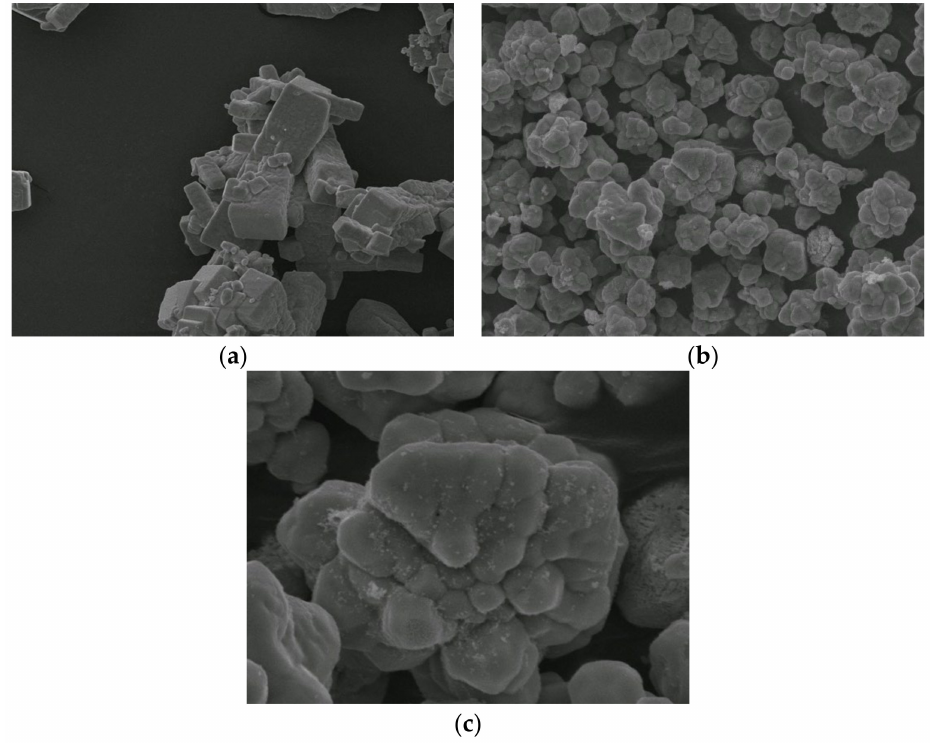
Figure 3. SEM images of ( a ) BiVO 4, ( b ) 1% Pd/BiVO 4 ( × 5000), and ( c ) 1% Pd/BiVO 4 ( × 20,000). TEM images of 1% Pd/BiPO 4 are displayed in Figure 4a,b, and the Pd nanoparticles loaded on the surface of BiVO 4 are observed. It seems that BiVO 4 has palladium not only on the surface but also in the inner structure. Figure 4a shows a nearly uniform distribution of black spots. In the TEM image with a larger magnification (Figure 4b), the crystalline lattice space obtained from the line width was 0.29 nm, which was identified as the (040) crystal plane of BiVO 4 . In addition, a 0.23 nm interfringe distance was observed, which was close to the lattice spacing of the (111) crystal plane of Pd. This result indicates the high dispersion of the Pd nanoparticles which could favor the electron collections. The elemental composition of the synthesized 1% Pd/BiVO 4 was elucidated using energy- dispersive X-ray spectroscopy analysis, and the result is shown in Figure 4c. Pd, Bi, V, and O elements were detected from the proposed Pd/BiVO 4 composite. This EDS result reveals that the obtained Pd/BiVO 4 does not contain other impurities. Combined with the aforementioned TEM and XRD results, the successful fabrication of high-purity Pd/BiVO 4 composite material can be